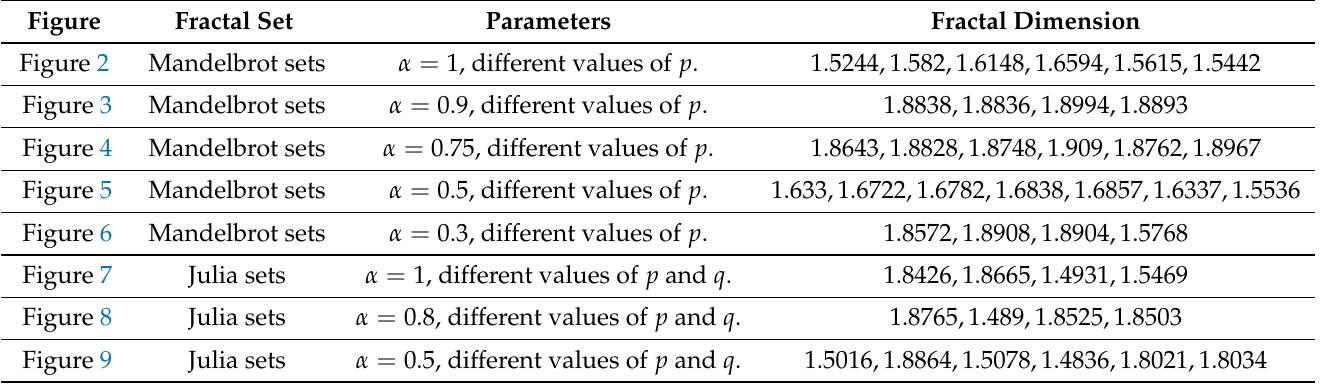
Table 1. Summary of cases considered in numerical simulations and the associated fractal dimensions. Figure Fractal Set Parameters Fractal Dimension Figure 2 Mandelbrot sets α = 1, different values of p . Figure 3 Mandelbrot sets α = 0.9, different values of p . Figure 4 Mandelbrot sets α = 0.75, different values of p . Figure 5 Mandelbrot sets α = 0.5, different values of p . Figure 6 Mandelbrot sets α = 0.3, different values of p . Figure 7 Julia sets α = 1, different values of p and q . Julia sets α = 0.8, different values of p and q . Julia sets α = 0.5, different values of p and q